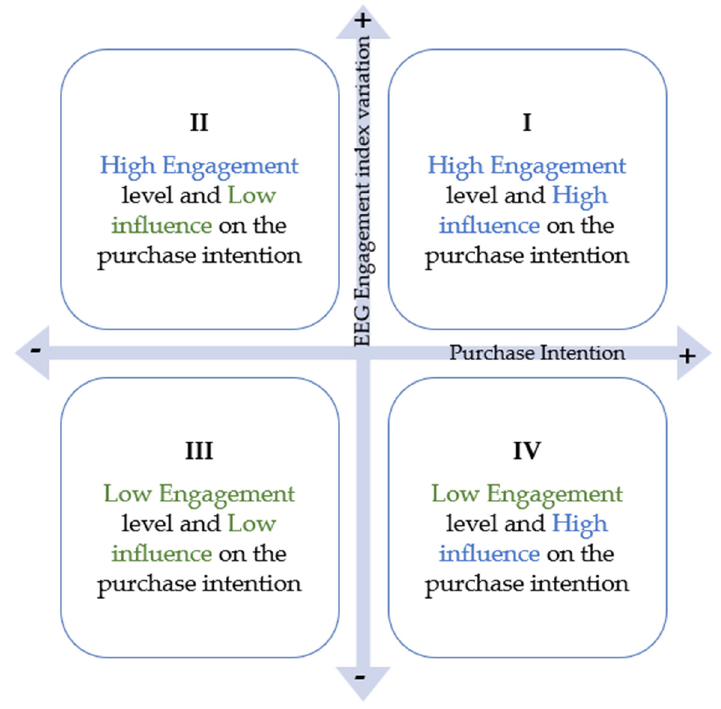
Figure 8. Quadrant model of EEG engagement index variation vs. UPI.